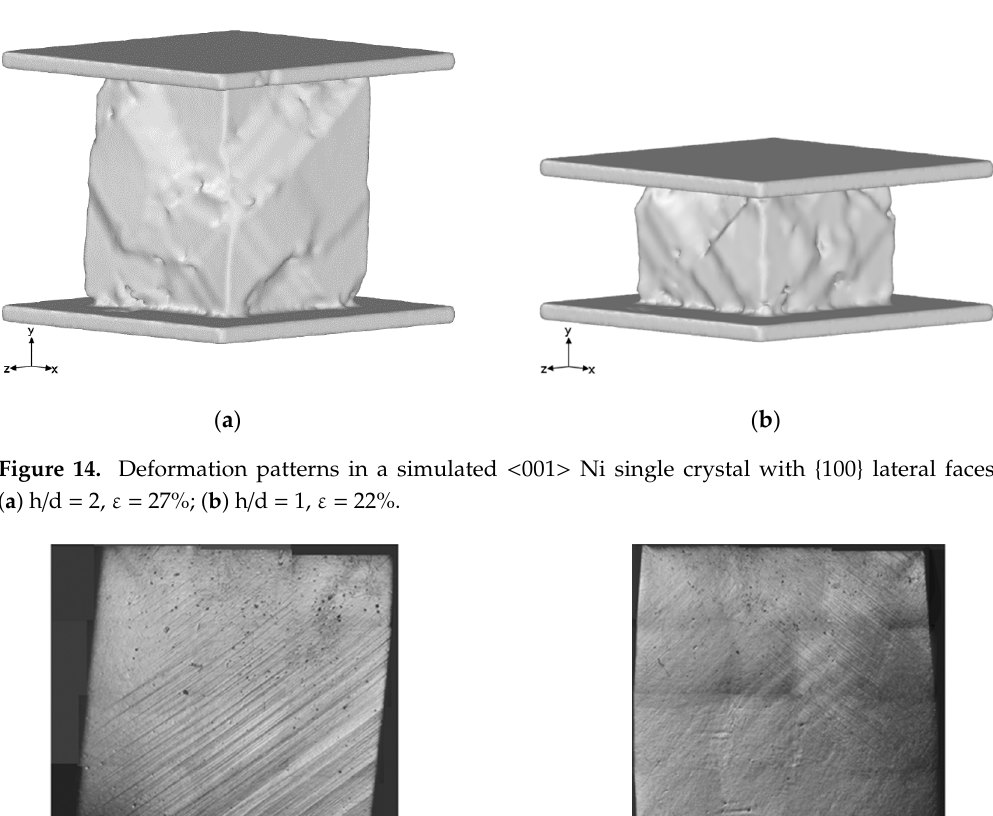
Figure 13. Deformation patterns in a simulated <001> single crystal with h/d = 1 and {100} lateral faces at a sequentially increasing strain of ( a ) 7.79%; ( b ) 7.89%; ( c ) 7.94%; ( d ) 12.59%; ( e ) 14.2% and ( f ) 21.5%.